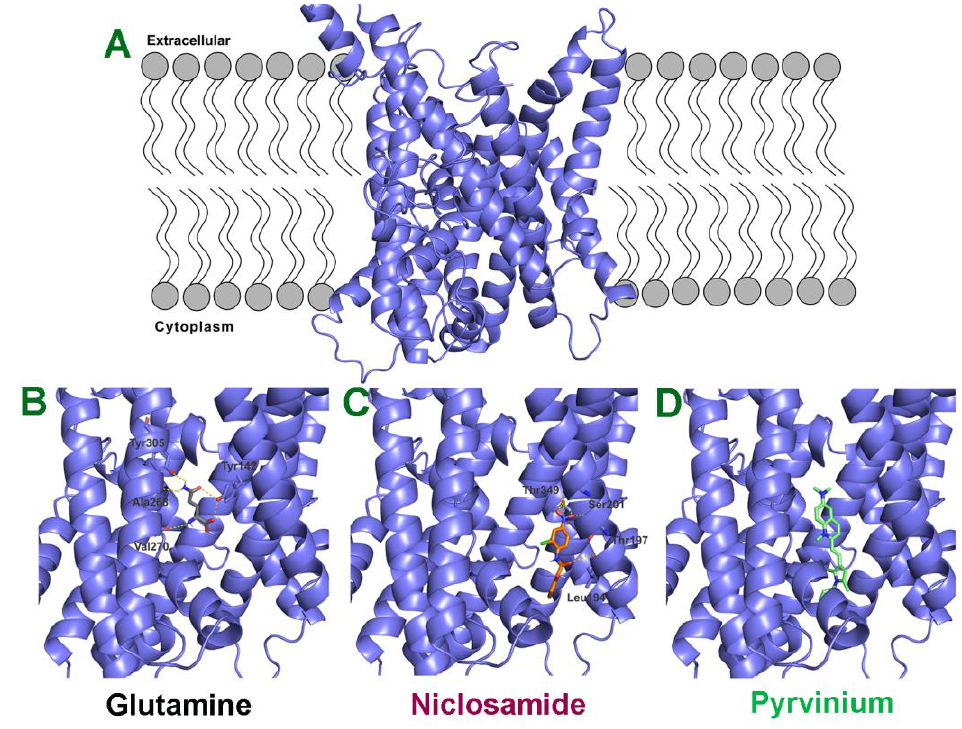
Figure 9. Molecular docking of glutamine, niclosamide and pyrvinium to SLC38A5. ( A ) Predicted model for SLC38A5 as it is present in the lipid bilayer. Binding of glutamine ( B ), niclosamide ( C ) and pyrvinium ( D ) to the binding pocket of SLC38A5. The ligands (glutamine, niclosamide and pyrvinium) are shown as stick models. The amino acid residues predicted to be involved in the binding of the three ligands are also shown.